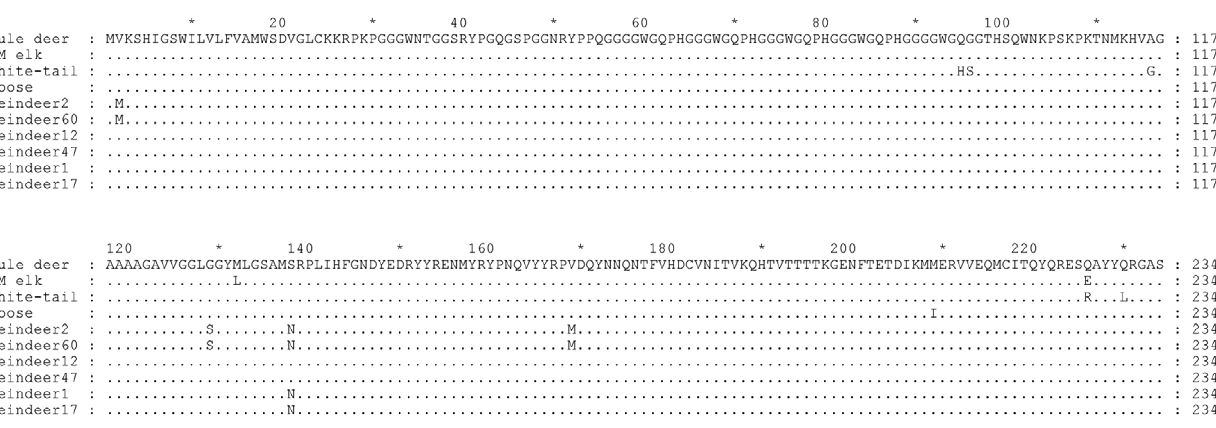
Figure 3. PRNP sequence of the reindeer used in this study compared with mule deer, white-tailed deer, Rocky Mountain elk, and moose. Reindeer are polymorphic at codons 2 (M/V), 129 (S/G), 138 (S/N), and 169 (M/V). PRNP polymorphisms have also been reported in Rocky Mountain elk (132 M/L), mule deer (20 D/G, 225 S/F), white-tailed deer (95 Q/H, 96 G/S, 116 A/G, 226 Q/R, and 230 Q/L) and moose 209 (M/I)